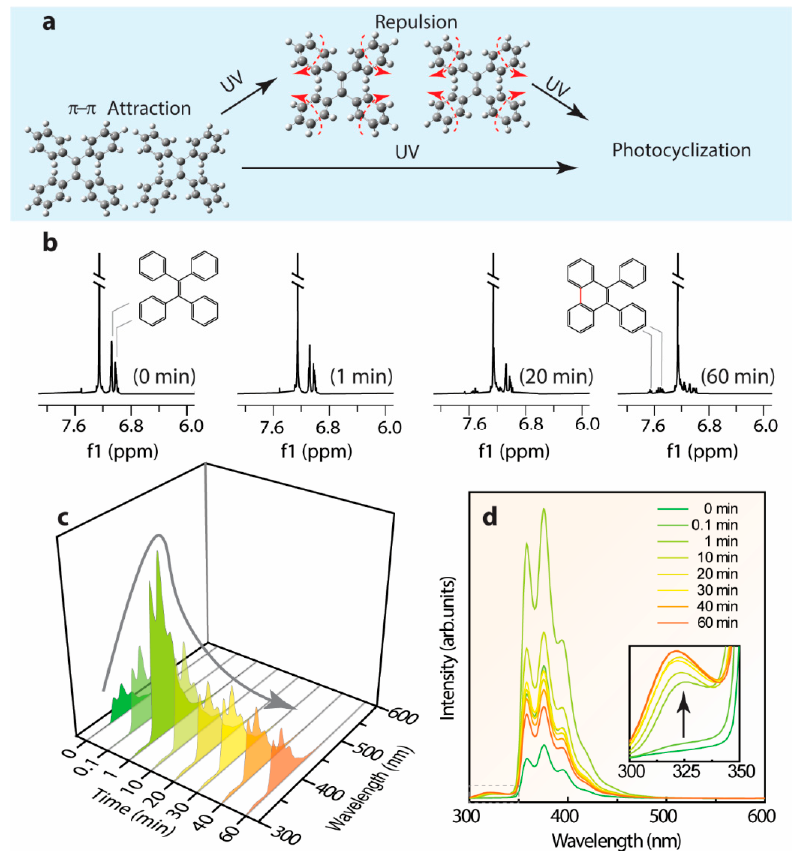
Figure 11. ( a ) The deduced molecular interaction of L-TPE (0.1 mg/mL) in low concentration under continuous long duration irradiance, and parallelly monitored time dependent ( b ) 1 H NMR and ( c , d ) emission spectra.